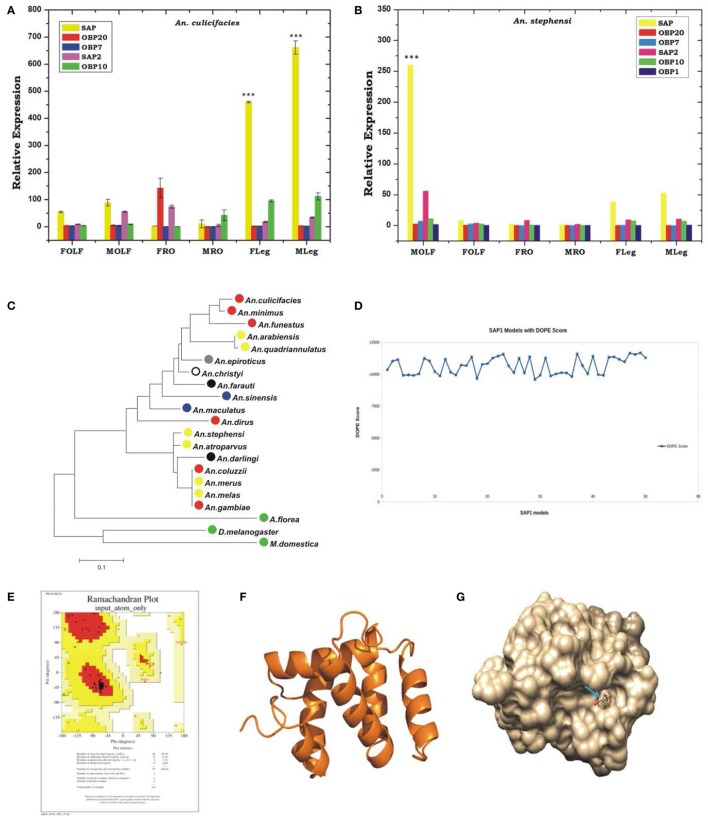
Comparative transcriptional responses of Odorant binding protein genes between two major Indian vectors and structural characterization of one of the potent OBP gene. (A,B) Sex and tissue-specific relative expression profiling of OBP genes in An. culicifacies
(A) and An. stephensi
(B). FOLF, female olfactory tissue (OLF); MOLF, Male OLF; FRO, Female reproductive organ; MRO, Male reproductive organ; FLeg, Female legs; MLeg, Male legs. OBP gene details: SAP, Sensory appendages protein 1; SAP2, Sensory appendages protein 2. (C) Phylogenetic analysis of An. culicifacies SAP1 (Ac-SAP1) gene. Color-coded circle represents the nature of the mosquitoes host preferences e.g., Red circle, Strongly Anthropophilic; Blue circle, Strongly Zoophilic; Yellow circle, Opportunistic Anthropohilic and/or Zoophilic; Black circle, moderate Anthropophilic; Gray circle, Moderate zoophilic; Blank Circle, Unknown; Green circle, non-blood feeder. (D) DOPE score analysis for SAP1. (E) Ramachandran Plot of SAP1 protein. (F) 3-dimensional protein structure of the Ac-SAP1 protein. (G) The binding site of SAP1 protein showed in space fill with nearby residues in stick form. ***p ≤ 0.0001.